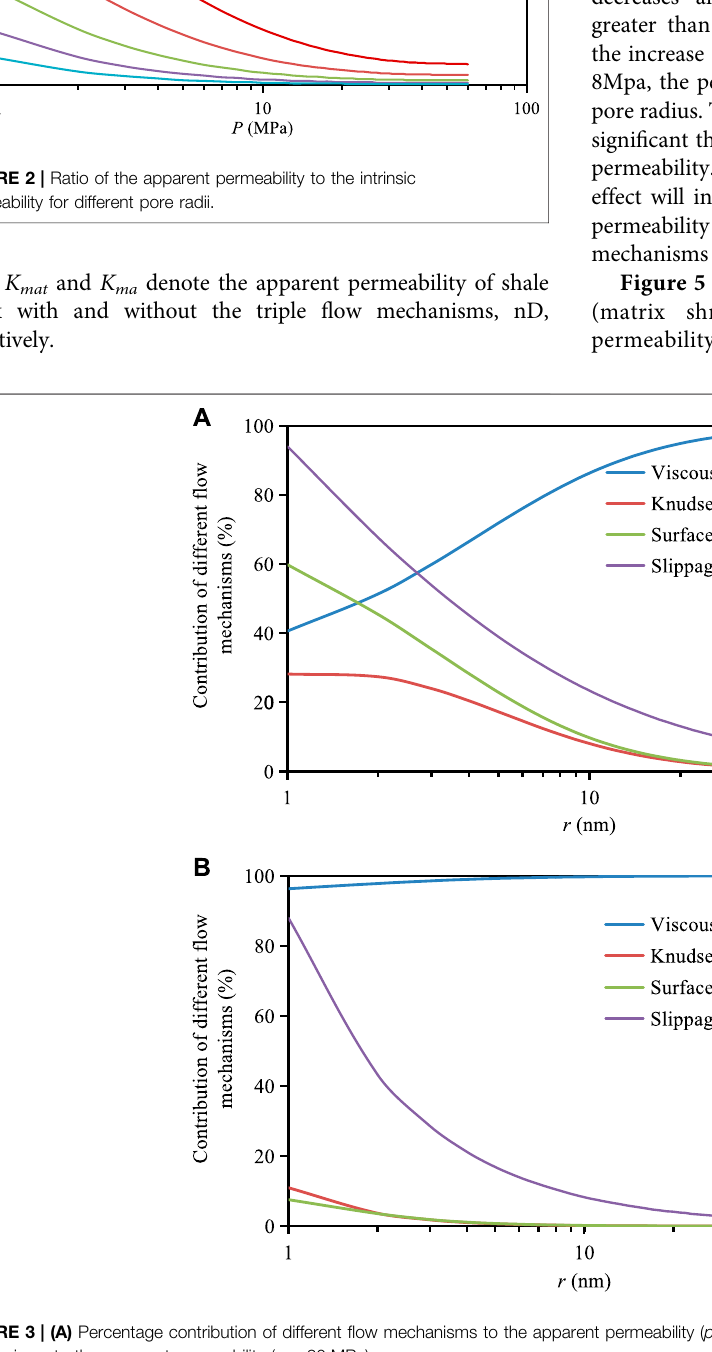
Frontiers in Earth Science |